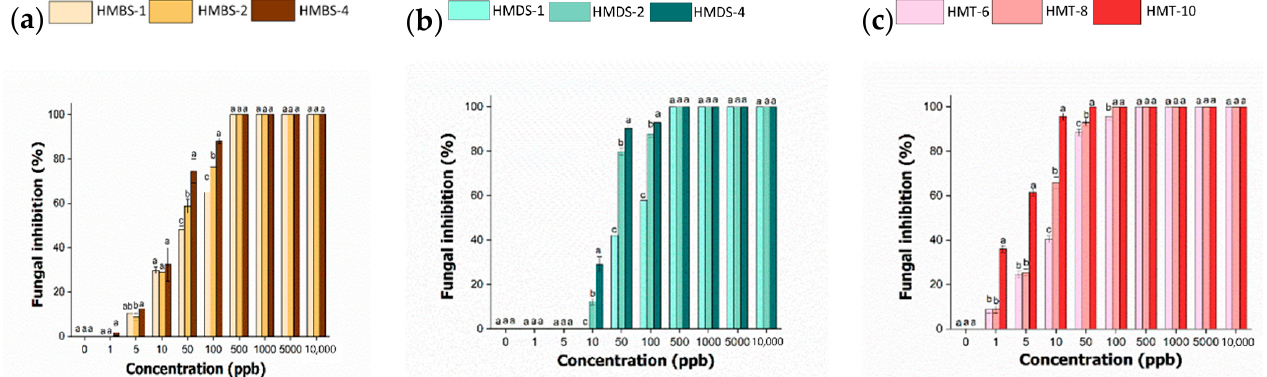
Figure 10. The percentage of inhibition radical growth (PIRG) against concentration (ppb) of hexaconazole-micelles nanodelivery systems based on different surfactants, HMBS ( a ), HMDS ( b ) and HMT ( c ) at day 7. Note: means that do not share a letter are significantly different, where p < 0.05 is considered a significant value.